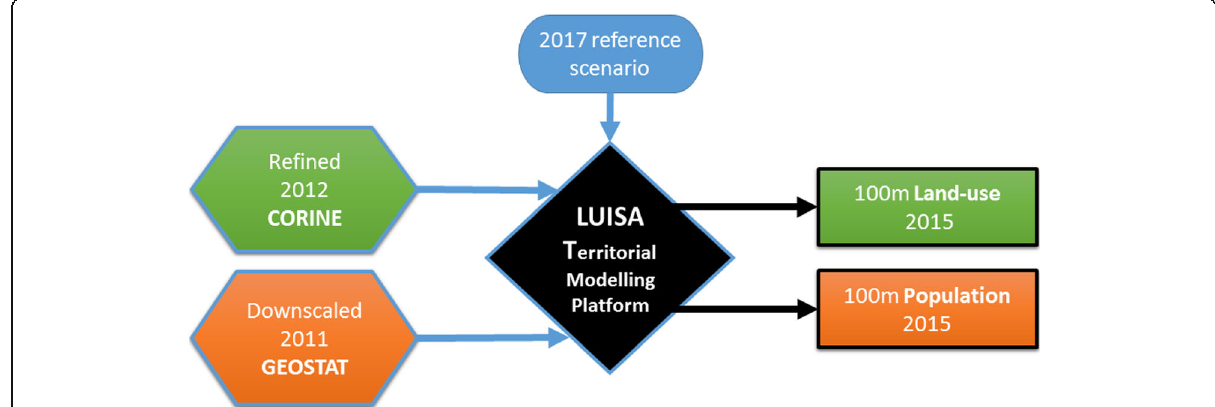
Fig. 2 flowchart illustrating the production process of the land-use and population data used in our approach